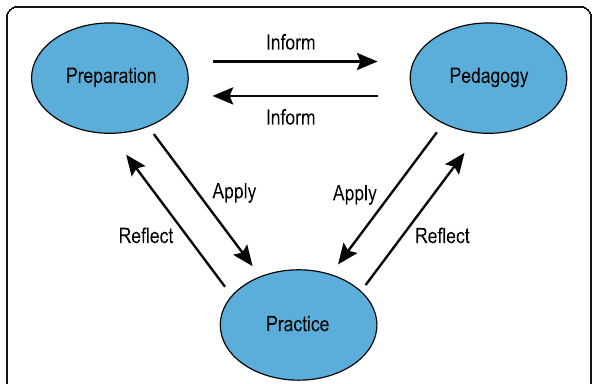
Fig. 1 The three essential elements of the LA program. Each week LAs meet with the instructional staff for their course (preparation) and in their pedagogy course (pedagogy) to reflect on their experiences with students (practice). LAs use the knowledge they gain in their pedagogy course to inform discussion with faculty during preparation, and in turn, use their experience with faculty to inform discussion with other LAs in their pedagogy class. Finally, the LAs apply what they learn in preparation and in their pedagogy class to their practice with students. Adapted from Otero et al.